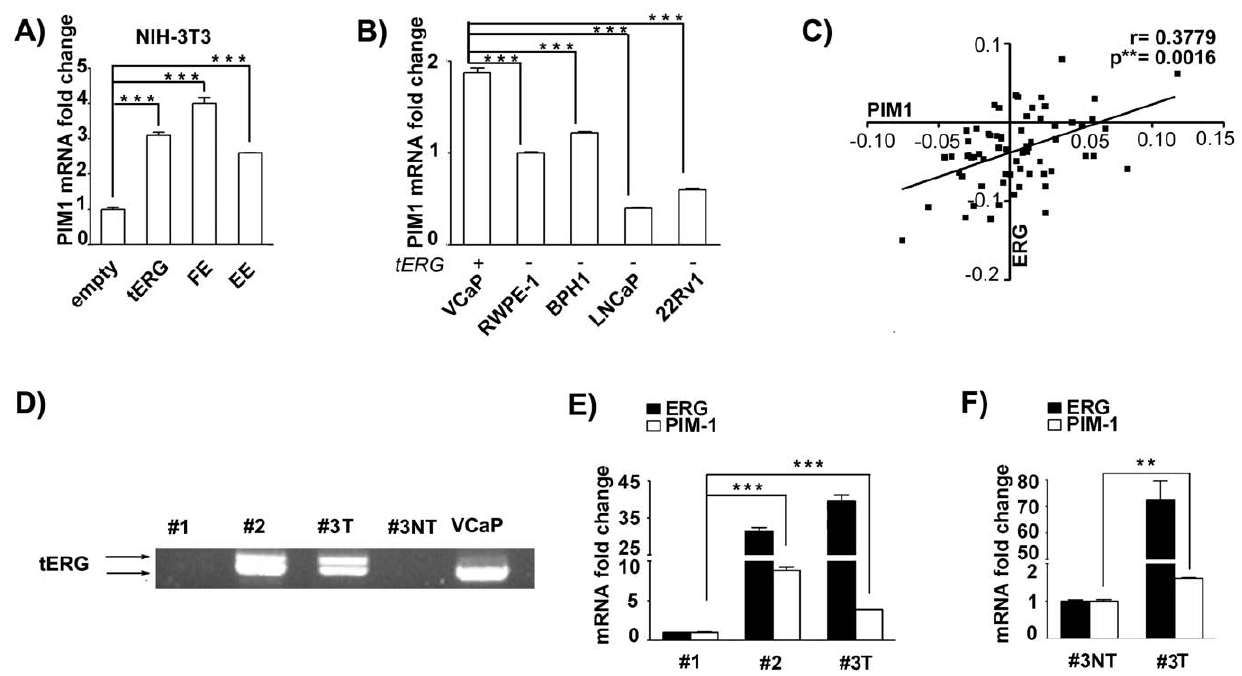
(Table 1). We used the Ingenuity Pathway Analysis (IPA) to